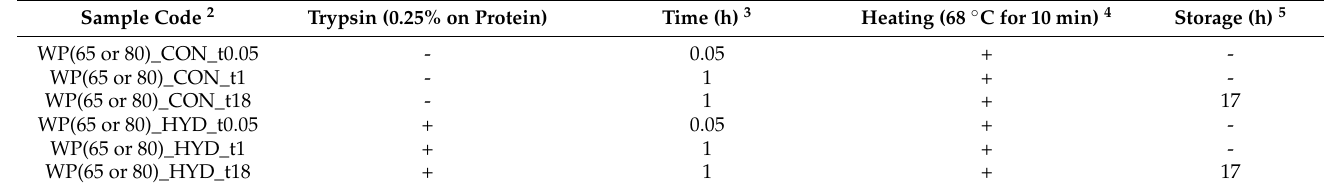
Table 1. Coding of samples taken from the tryptic hydrolysates (HYD) of whey protein concentrates (WPC) of sheep/goat origin manufactured from Feta cheese whey and of the respective controls (CON). WP65, WPC with 65% protein content; WP80, WPC with 80% protein content 1 . Sample Code 2 Trypsin (0.25% on